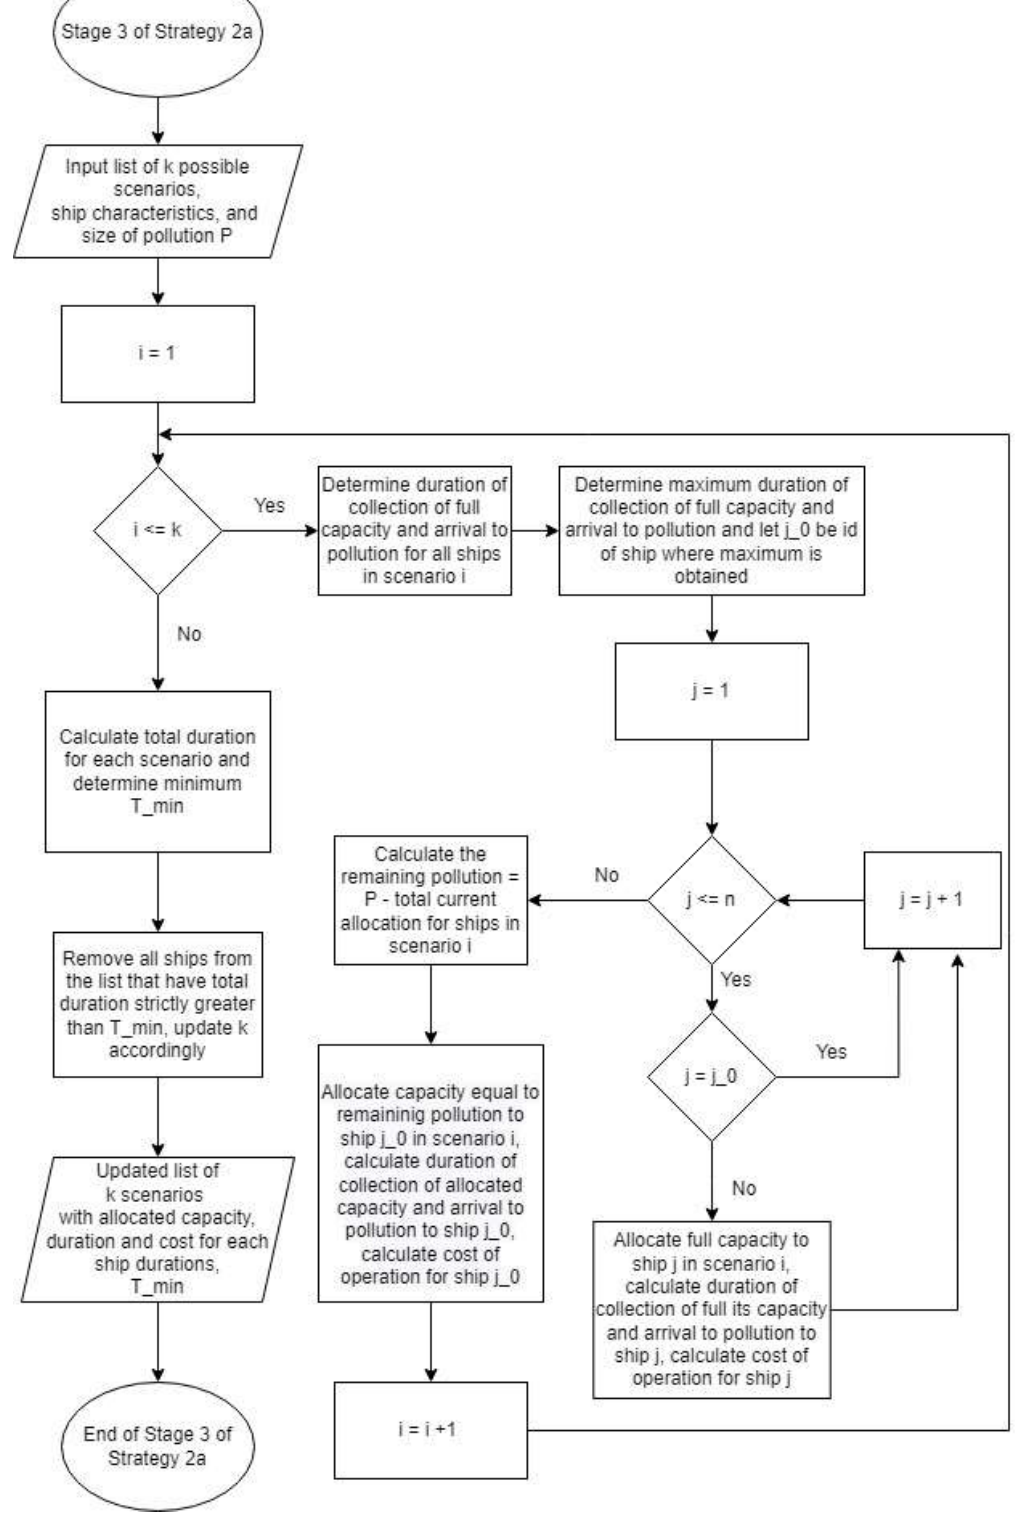
Figure 11. Flowchart for Stage 3 of Strategy 2a.